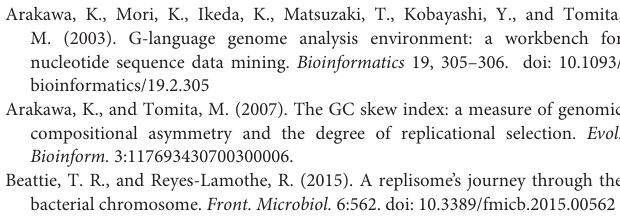
FIGURE S4 | Cumulative GC skew profiles of cyanobacterial species not shown in Figure 1B . Nostoc azollae possesses a pseudo- dnaA gene, which is disrupted by insertion of a transposon. Other details are described in Figure 1 . FIGURE S5 | Cumulative CDS skew profiles of cyanobacterial species not shown in Figure 1B . The details are described in Figure 1 . FIGURE S6 | Growth and chromosomal replication of Synechococcus sp. PCC 7002 (cid:49) dnaA strains. (A) High-throughput genomic DNA reads of WT and (cid:49) dnaA strains analyzed using IGV software. Genomic positions (1–3000 bases) including dnaA are shown. (B) Growth of (cid:49) dnaA clones not shown in Figure 4 . (C) Frequency of cells exhibiting 0 (blue), 1 (red), 2 (deep blue), or ≥ 3 (green) SSB-GFP foci in (cid:49) dnaA clones not shown in Figure 4 . TABLE S1 | Primers used in this